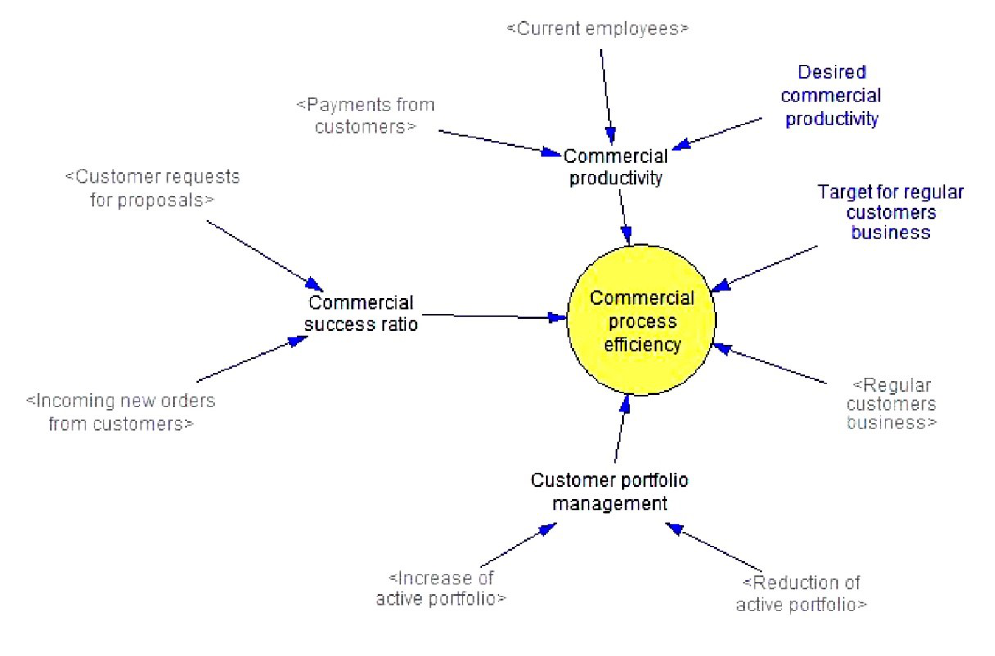
Fig. 3. Measurement of commercial process efficiency (developed by the